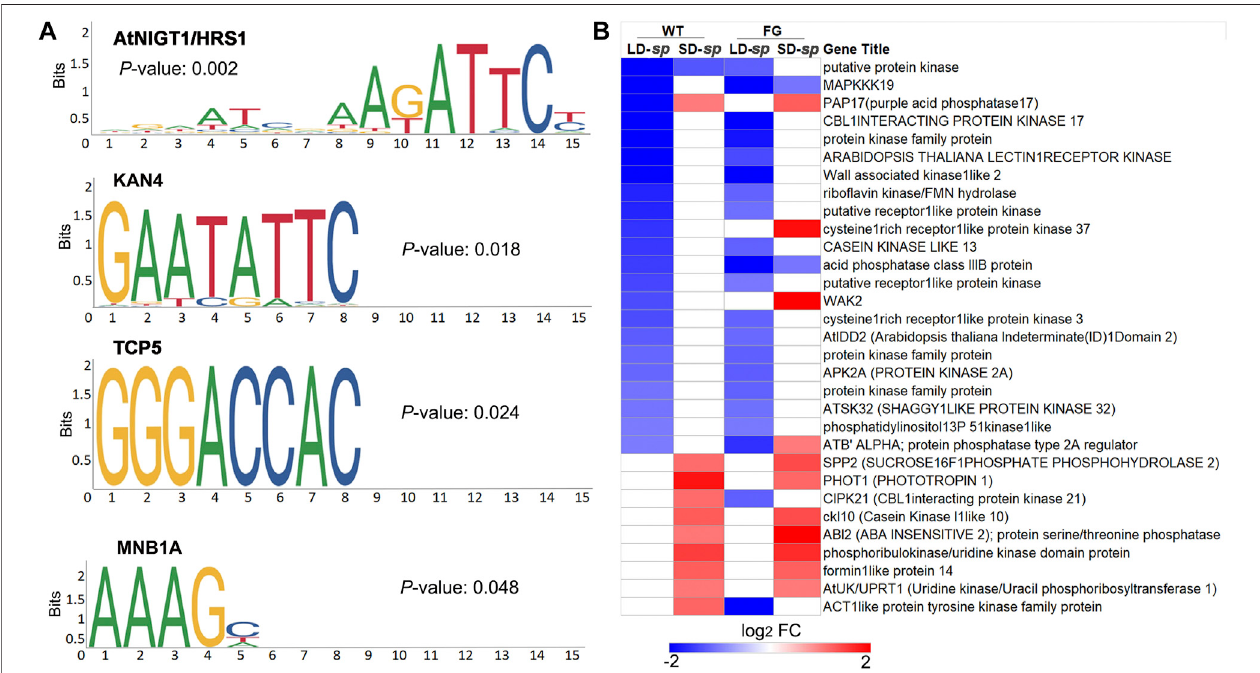
FIGURE 7 | Potential regulator of co-regulated genes in protein phosphorylation functional cluster of ‘ daylength-space related ’ genes of WT and FG. (A) Four overreprented motifs enriched in upstream promoter sequences of genes in protein phosphorylation GO category in Figure 6B,C , as detected by the plant regulomics (bioinfo.sibs.ac.cn/plant-regulomics). Indicated are the p -Value representing the statistical signi fi cance of the motif. (B) Clustering analysis of the selected coregulated genes in protein phosphorylation GO category in Figures 6B,C , which changed transcript abundance in response to space fl ight in WT and FG plants under long- day(LD)andshort-day(SD)conditions,respectivelyandhaveAtNIGT1/HRS1,KAN4,TCP fi veandMNB1Abindingsitesinupstreampromoterregions.LD- sp ,Genesof plantsundertheLDdifferentiallyexpressedinspaceincomparisonwiththeircontrolsonground.SD- sp , GenesofplantsundertheSDdifferentiallyexpressedinspacein comparison with their controls on